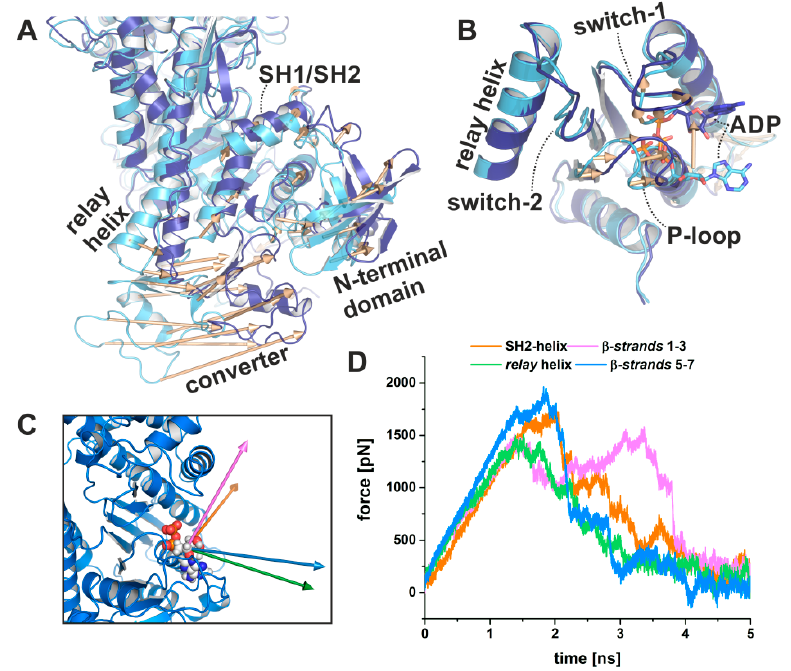
Figure 7. Pulling MD simulations using biasing forces on the converter domain visualize coupled conformational transitions in myosin and ADP dissociation. ( A ) Targeted molecular dynamics (TMD) simulations of the converter rotation from the up position of a strong-ADP-bound myosin conformation with closed actin-binding cleft and partially twisted transducer (light blue) towards the down position (dark blue) were coupled to rearrangements of the N-terminal domain. Structural changes are indicated by vectors. ( B ) The induced converter rotation during the TMD simulations led to a significant ~6 Å shift of the P-loop towards the front entrance of the active site. The bound ADP moved together with the P-loop towards the surface and lost interactions, which finally led to larger fluctuation of the nucleotide, and the population of a conformation similar to the myosin-II · ADP · blebbistatin crystal structure. ( C ) Visualization of the release vectors used to pull the nucleotide out of the crystallized position in the myosin motor domain. ( D ) Pulling forces required to dissociate ADP from myosin along the four di ff erent vectors. Independent of the release vector, a consistent set of interactions was involved in ADP dissociation. Shown are the averages of duplicate steered MD simulations.